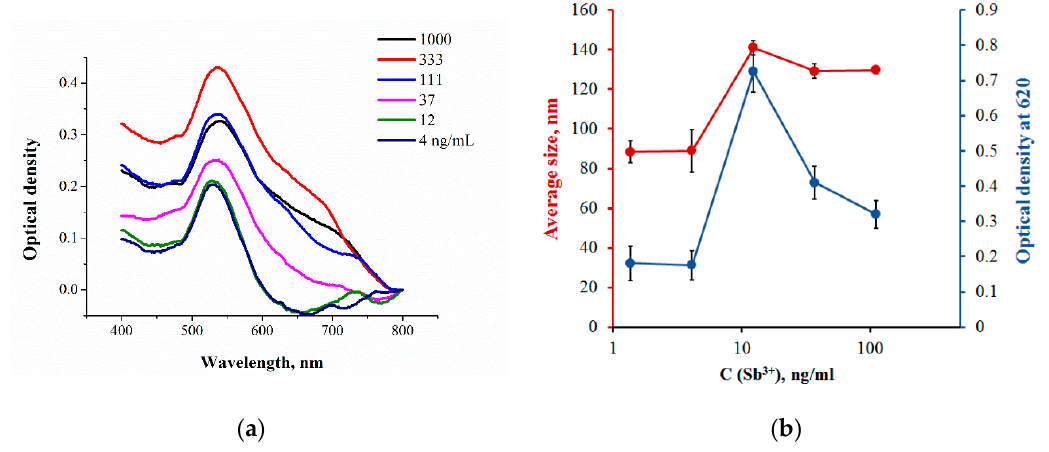
Figure 5. ( a ) The absorbance spectra of PAO-immobilized GNPs after different additions of Sb 3+ (normalized spectra, after subtracting the corresponding background signal); ( b ) the value of optical density (lower) and average hydrodynamic diameter (upper) of conjugated GNPs. All experiments were undertaken in three replicates.